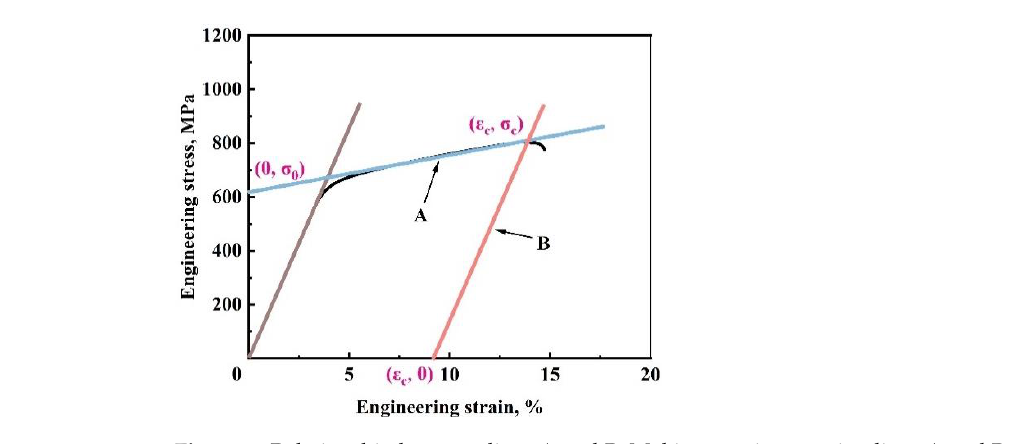
Figure 8. Relationship between lines A and B. Making two intersecting lines A and B at the breaking stress point shows the relationship between σ c and ε c .